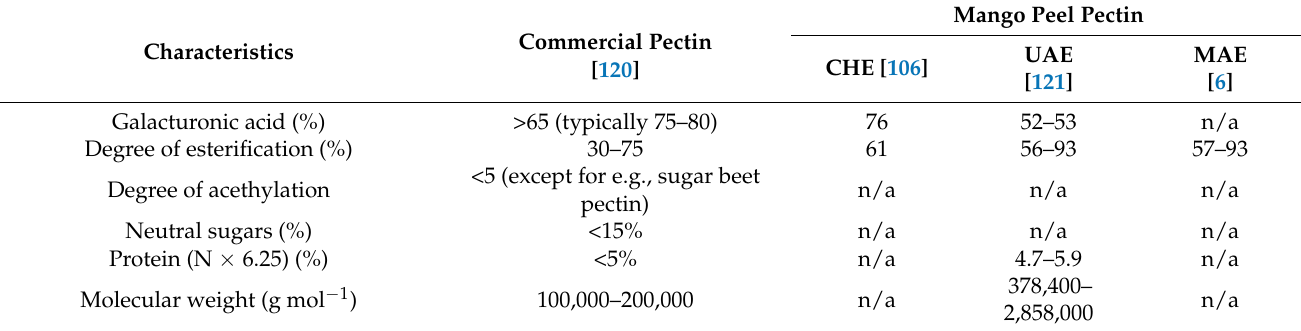
Table 5. Typical characteristics of mango peel pectin compared with commercial pectin.